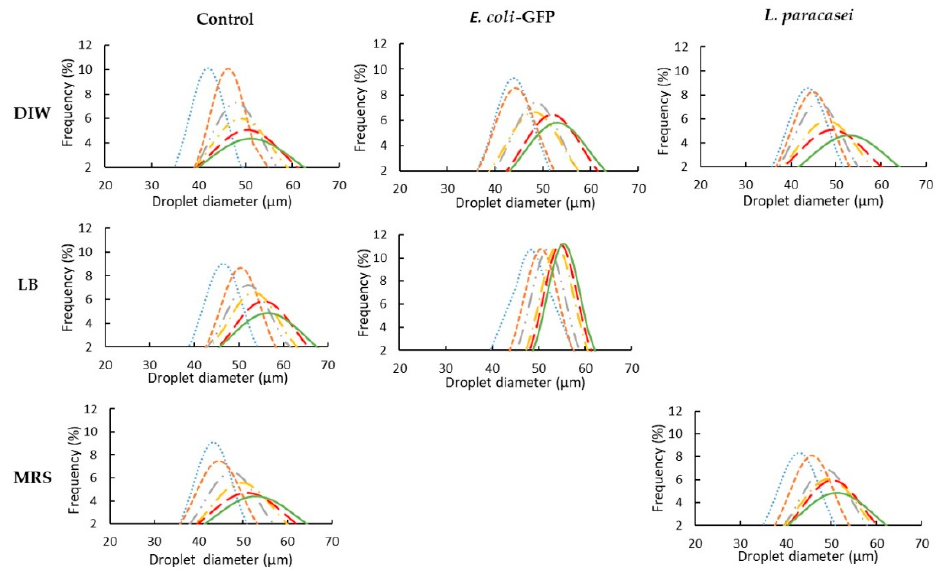
Figure 2. Droplet size distribution at Day 0: blue ( ···· ), Day 1: orange (—-), Day 2: grey (- ·· ), Day 3: yellow (- · -), Day 4: red (- - -), Day 5: green (——). Frequency (%) refers to the percentage of droplets. Data was analysed with N = 900 droplets.